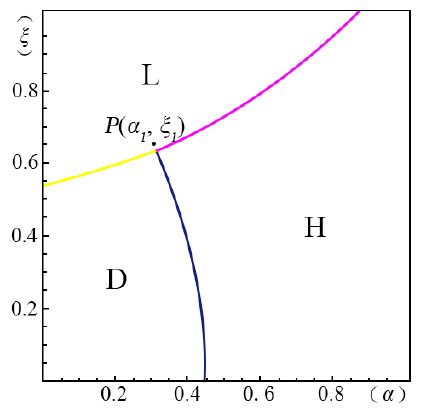
(cid:3043) (cid:3118)(cid:3250) (cid:2879)(cid:3043) (cid:3117)(cid:3250) (cid:3409) (cid:3043) (cid:3117)(cid:3250) (cid:2879)(cid:3043) ≤ p 1 A − p . λσδ Q − 1 σδ Q ( 1 − λ ) (cid:3097)(cid:3083)(cid:3018)(cid:4666)(cid:2869)(cid:2879)(cid:3090)(cid:4667) (cid:3090)(cid:3097)(cid:3083)(cid:3018)(cid:2879)(cid:2869)